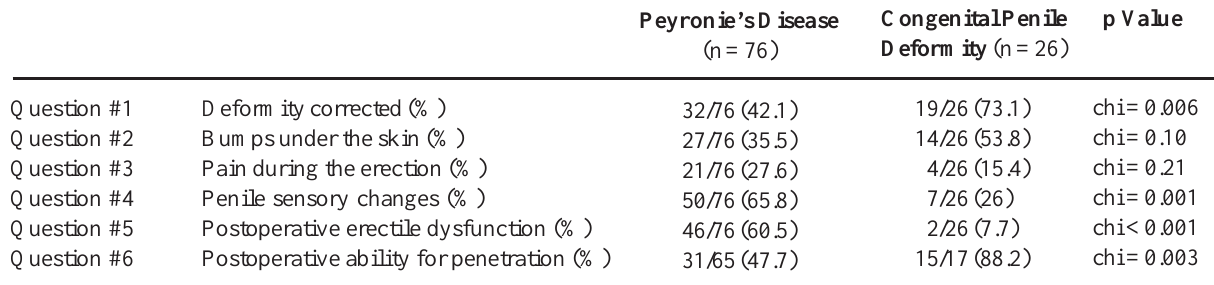
Table 2 – Postoperative results according to patient interview. Denominator used for the analysis of question #6 was different since only patients complaining of difficulties for preoperative vaginal intromission were taken into account for